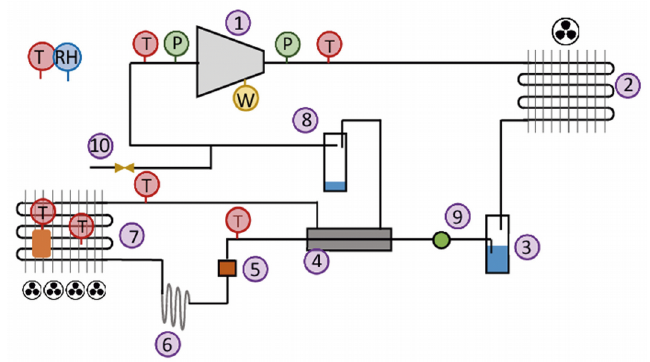
Figure 6. Schematic of the cooling system